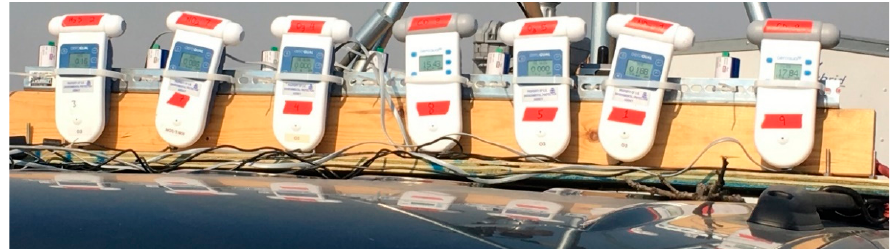
Figure 3. Close-up photograph of Aeroqual and Cairpol sensors mounted to the roof of the sampling vehicle. pling